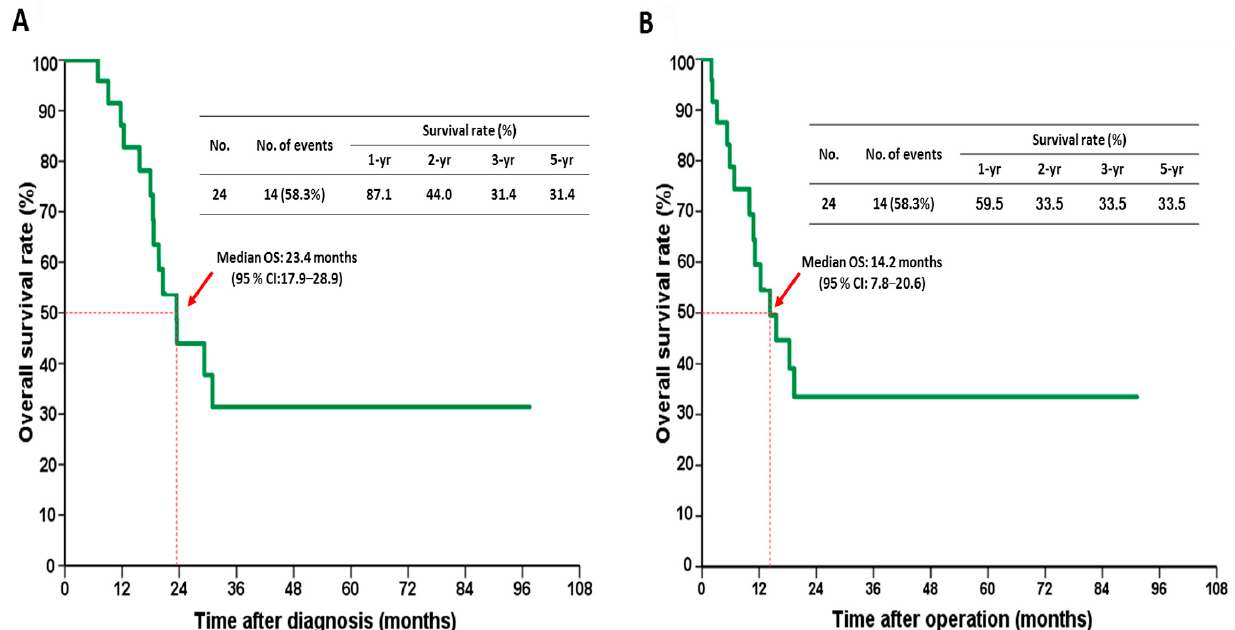
Figure 2. Kaplan–Meier survival curves after the ( A ) initial diagnosis and ( B ) operation in the conversion surgery group.